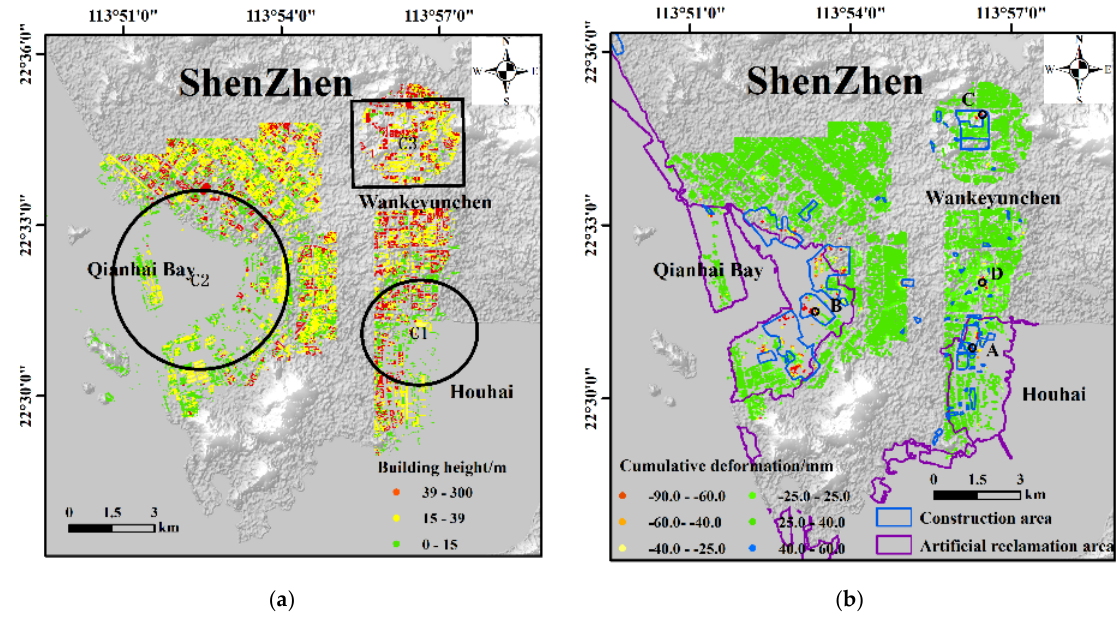
Figure 8. ( a ) Contour and height of buildings based on LiDAR data; ( b ) artificial reclamation area, construction area and vertical deformation rate of buildings from March 2017 to April 2020 based on Sentinel-1A images. Locations of time series data: A = Ali Center, B = Qianwan law building, C = Vanke Cloud city, D = and Yuehaimen zone.